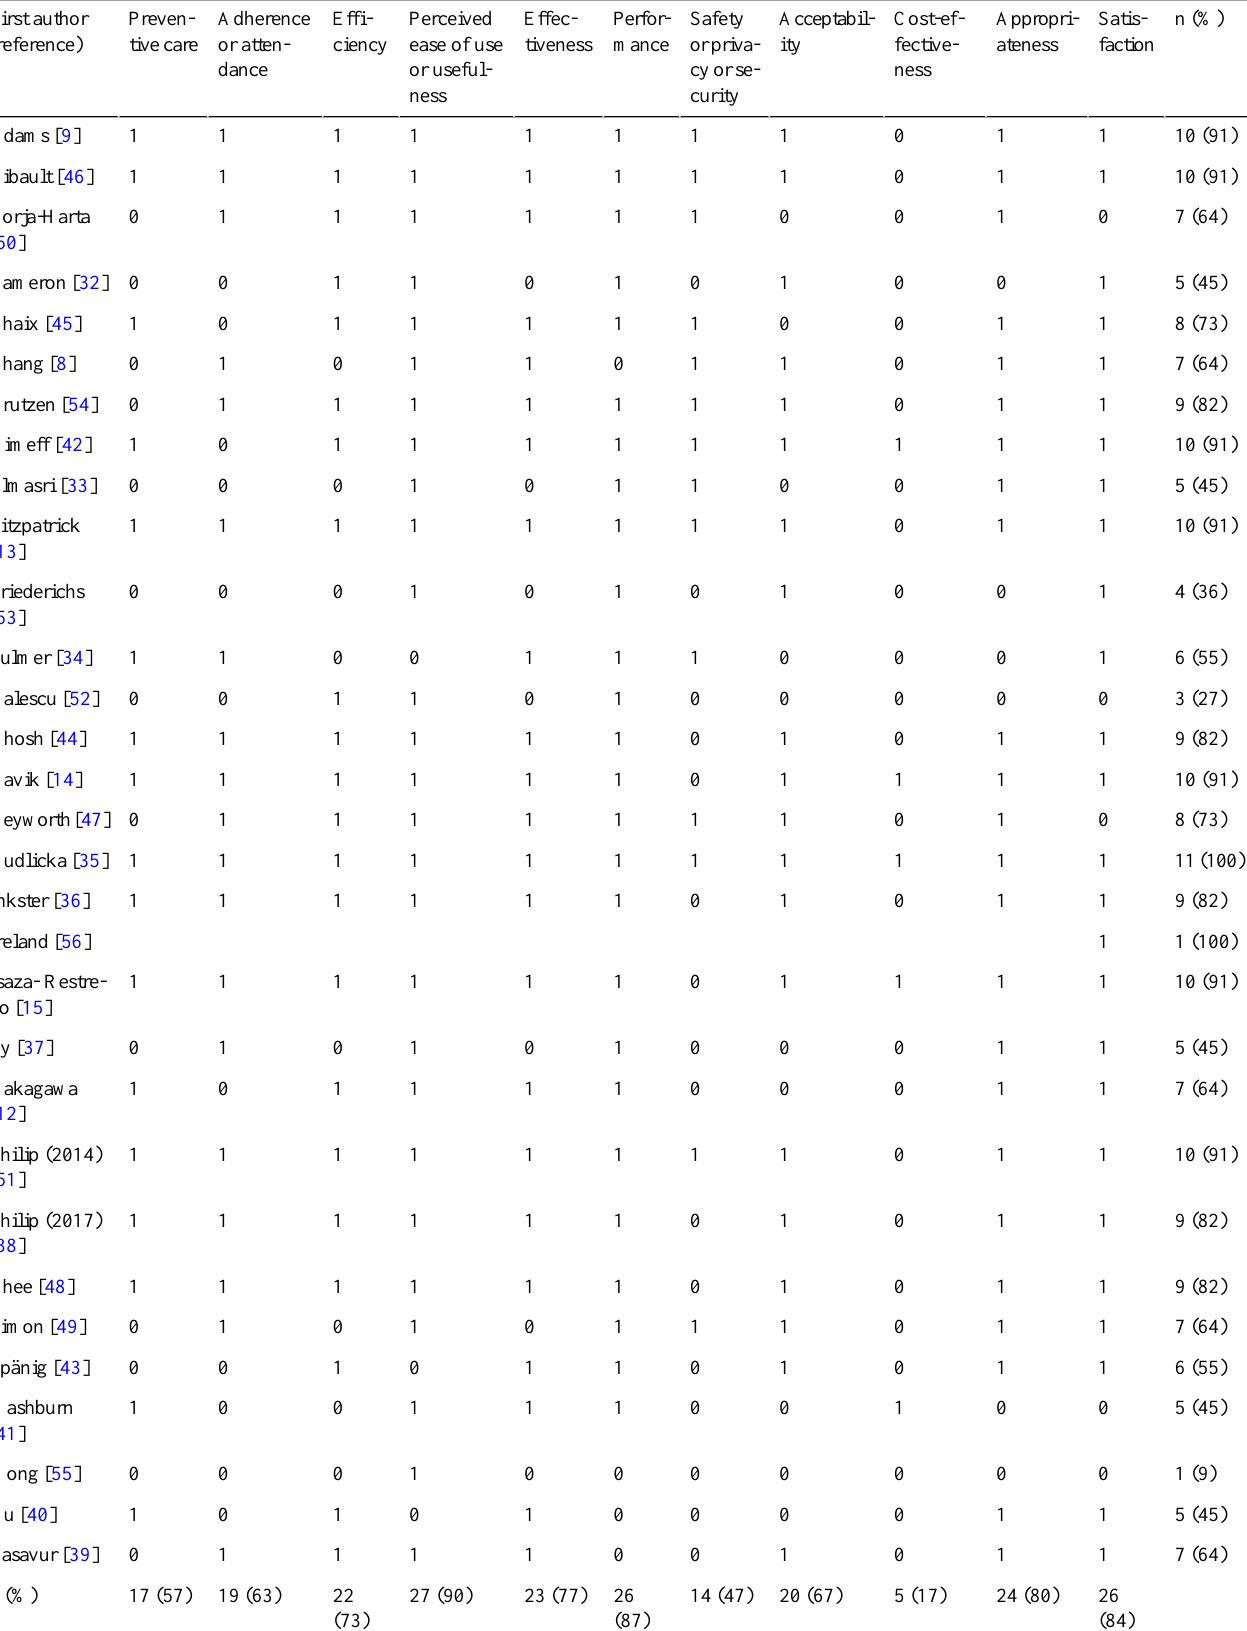
Table 2. Summary of the studies based on the evaluation outcomes from the synthesis framework for the assessment of health information technology a .